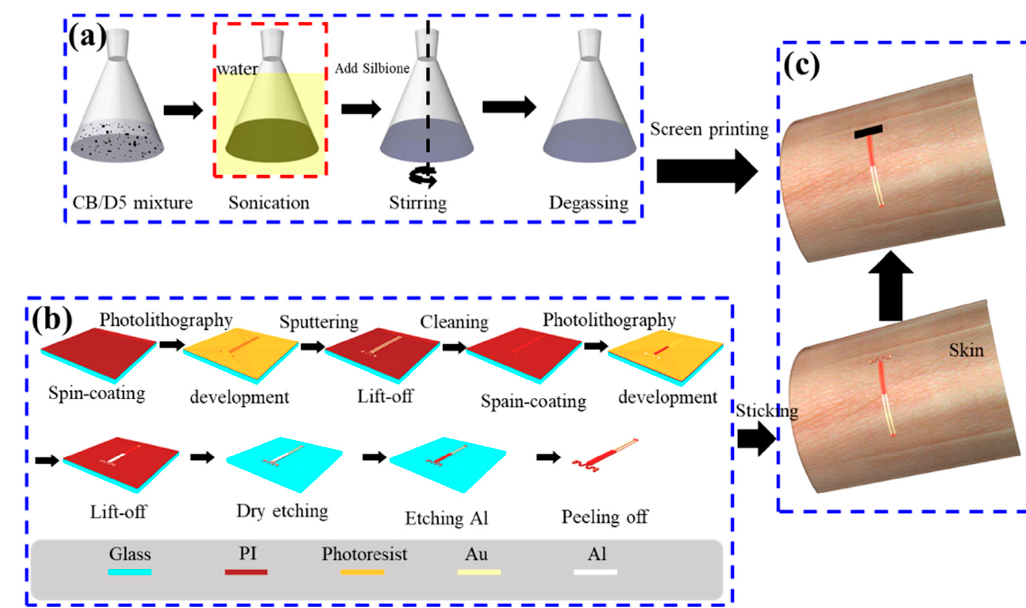
Figure 2. Schematic diagram of the fabrication process of the EES: ( a ) Synthesis process of the ternary conductive nanocomposite. ( b ) Fabrication process of the connector: ( c ) Assembling process of the EES.